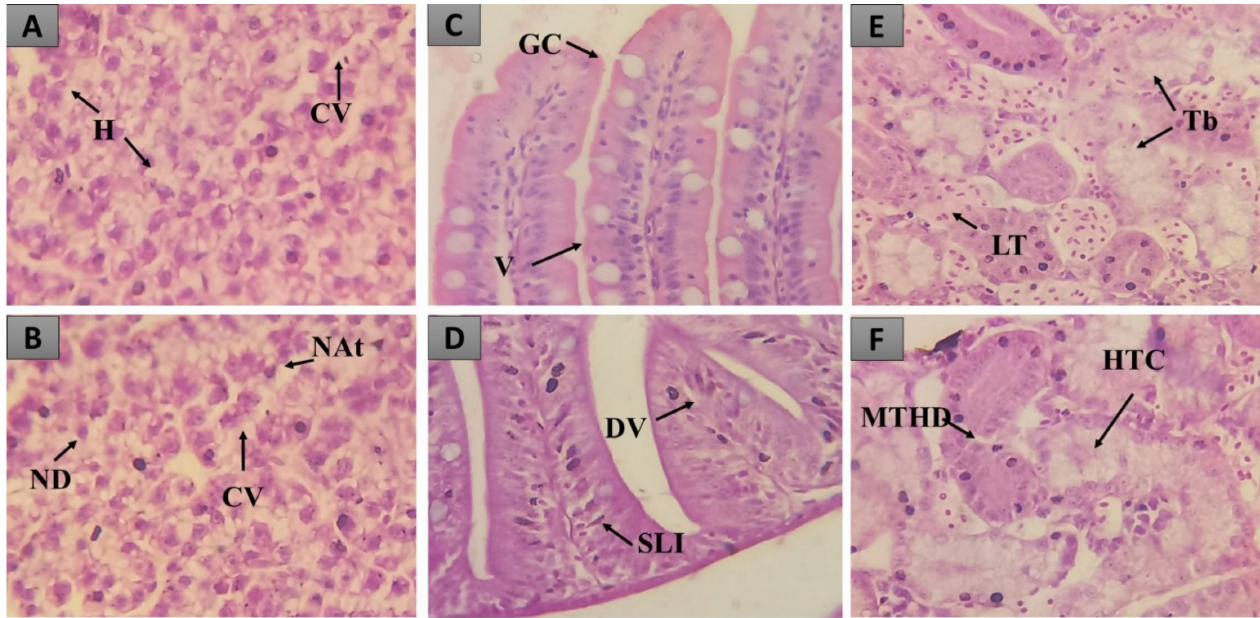
Figure 4. Histopathological changes observed in the liver, intestine and kidneys of zebrafish treated with the HELTr 2000 mg/kg dose. In ( A , B ), there are observed normal hepatocytes in the liver tissue (H), cytoplasmic vacuolization (CV), nuclear atypia (NAt) and nuclear degeneration (ND). In ( C , D ), intestinal tissue with normal goblet cells (GC), villi (V), the dilation of the vessels present in the villi (VD) and stromal leukocyte infiltration (SLI) can be seen. In ( E , F ), renal tissue with normal tubules (Tb) and lymphoid tissue (LT), mild tubular hyaline degeneration (MTHD) and tubular cell hyperplasia (HTC) can be observed. H&E